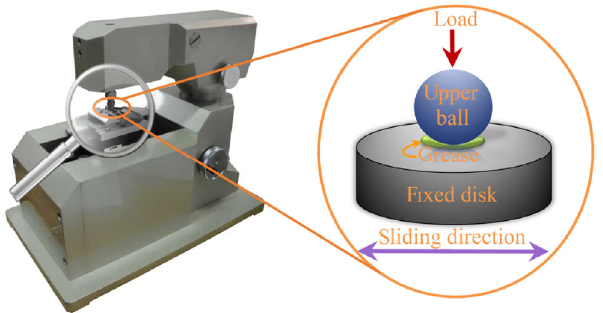
Fig. 3 The MFT-R4000 reciprocation tribometer and contact configuration of the friction